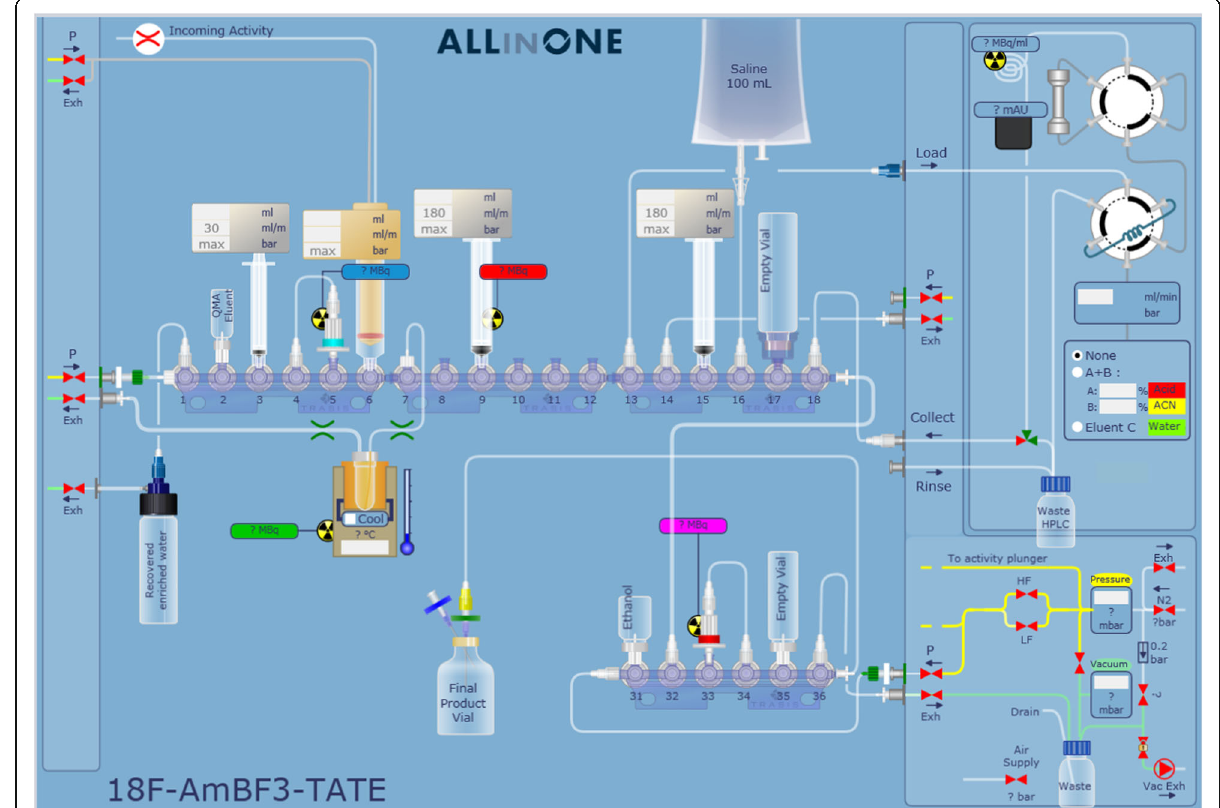
Fig. 2 Setup of the synthesis cassette to produce [ 18 F]AmBF 3 -TATE with integrated HPLC purification on Trasis AllInOne